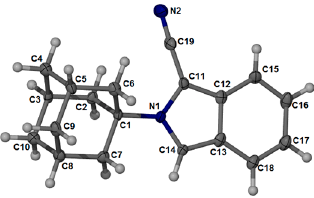
Figure 1. The asymmetric unit of compound 1 showing the atomic numbering scheme and 30% probability displacement ellipsoids of non-H atoms.